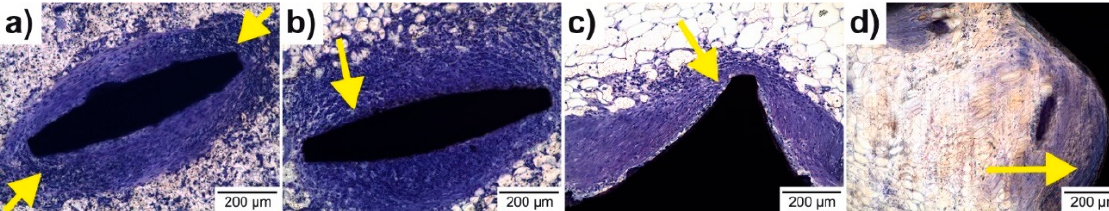
Figure 10. Peri-implant inflammation (marked by yellow arrows) ( a ) 120 days after experimental screw implantation, ( b ) 240 days after experimental screw implantation, ( c ) 360 days after experimental screw implantation, ( d ) 360 days after Ti-based screw